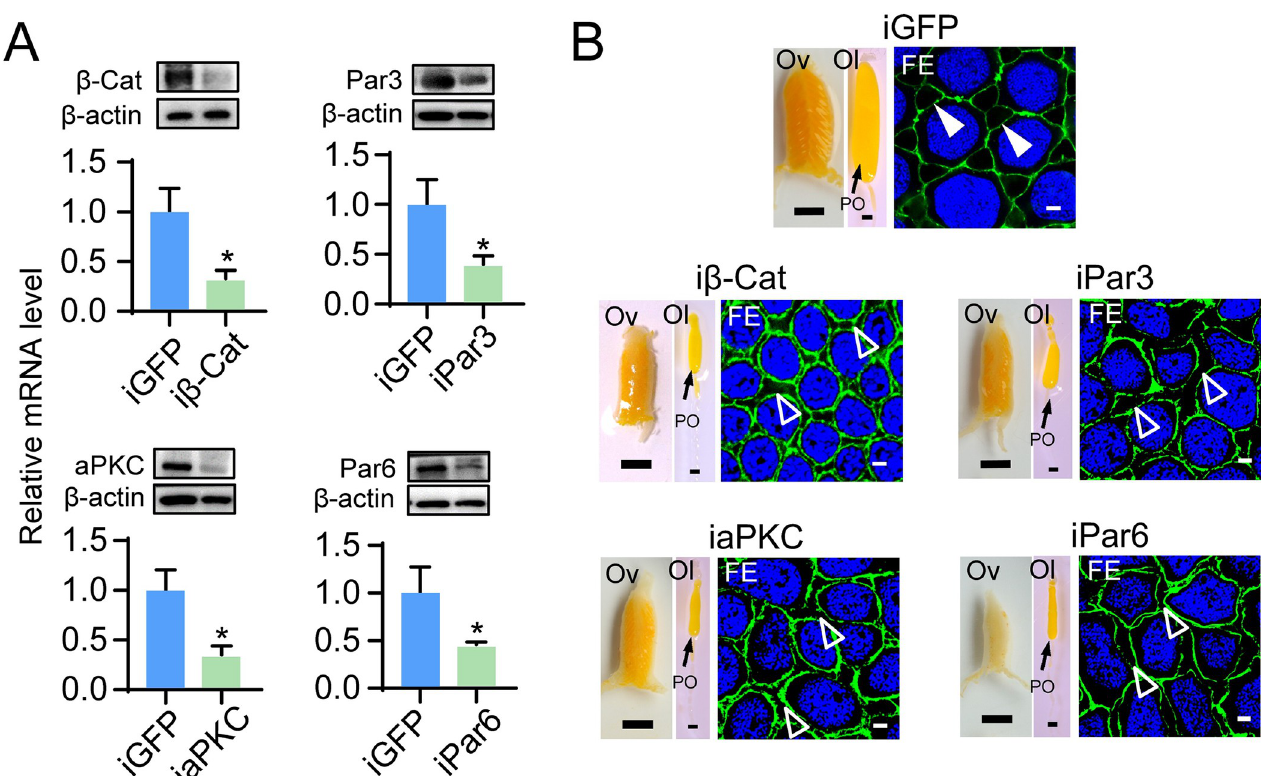
Fig 2. Effect of β -Cat , Par3 , aPKC and Par6 knockdown on patency and vitellogenesis. (A) qRT-PCR and Western blot showing RNAi-mediated knockdown efficiency of β -Cat (i β -Cat), Par3 (iPar3), aPKC (iaPKC) and Par6 (iPar6) in the ovary of adult females at 8 days PAE. � , P < 0.05. n = 6–8. (B) Representative phenotypes of follicular epithelium (FE), primary oocytes (Po), ovarioles (Ol) and ovaries (Ov) of adult females subjected to β -Cat , Par3 , aPKC or Par6 RNAi. Arrow heads indicate patency. Empty arrow heads indicate break of bicellular junctions. Scale bars: ovary, 5 mm; ovariole, 0.5 mm; follicular epithelium, 5 μ